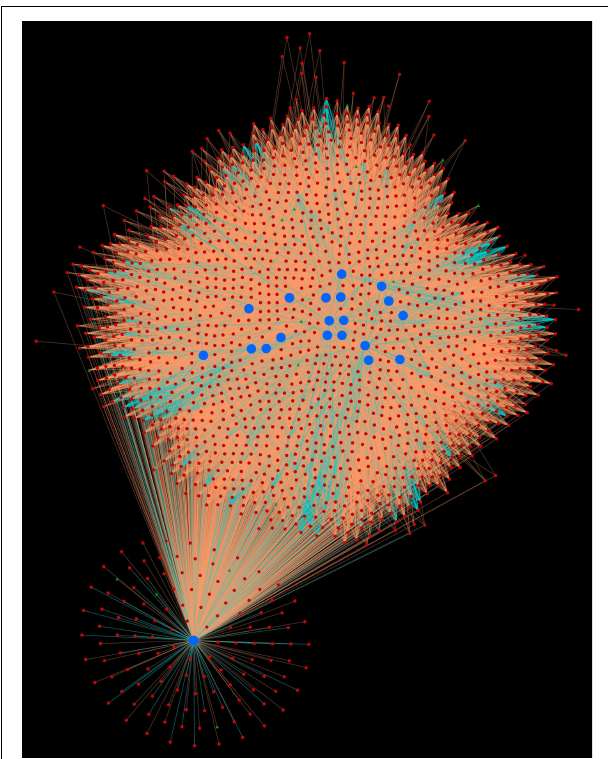
FIGURE 1 | Protein-protein interaction network for top 20 host protein hubs. Blue nodes represent host proteins, red nodes are pathogen proteins, and green nodes are effector proteins. Orange edges depict the interactions from interolog-based approach, while cyan edges belong to domain-based